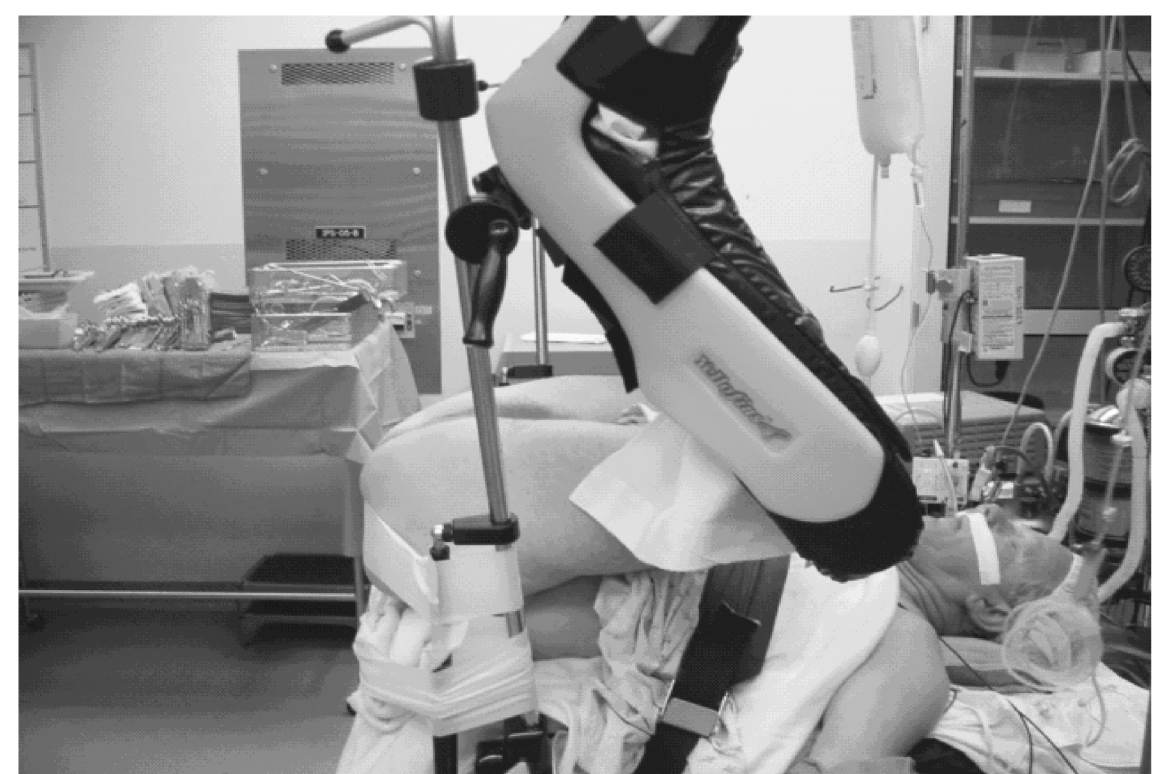
Figure 4 – The exaggerated lithotomy position for radical perineal